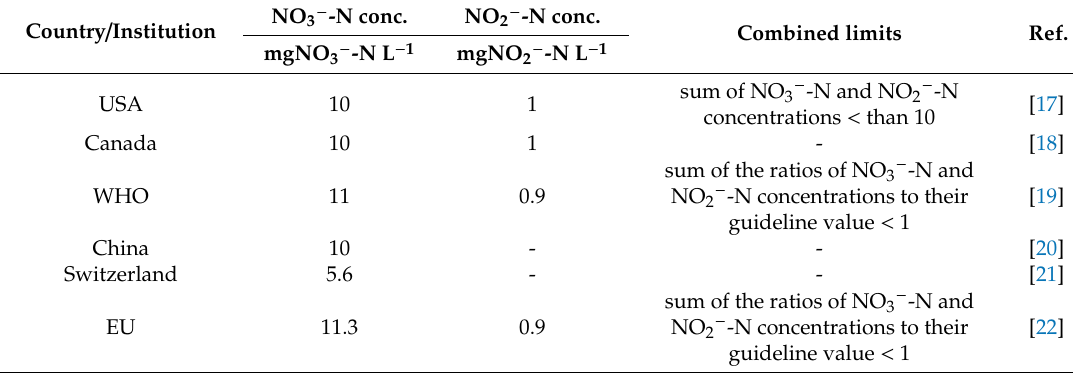
Table 1. Limits for nitrate and nitrite in drinking water in national regulations and international